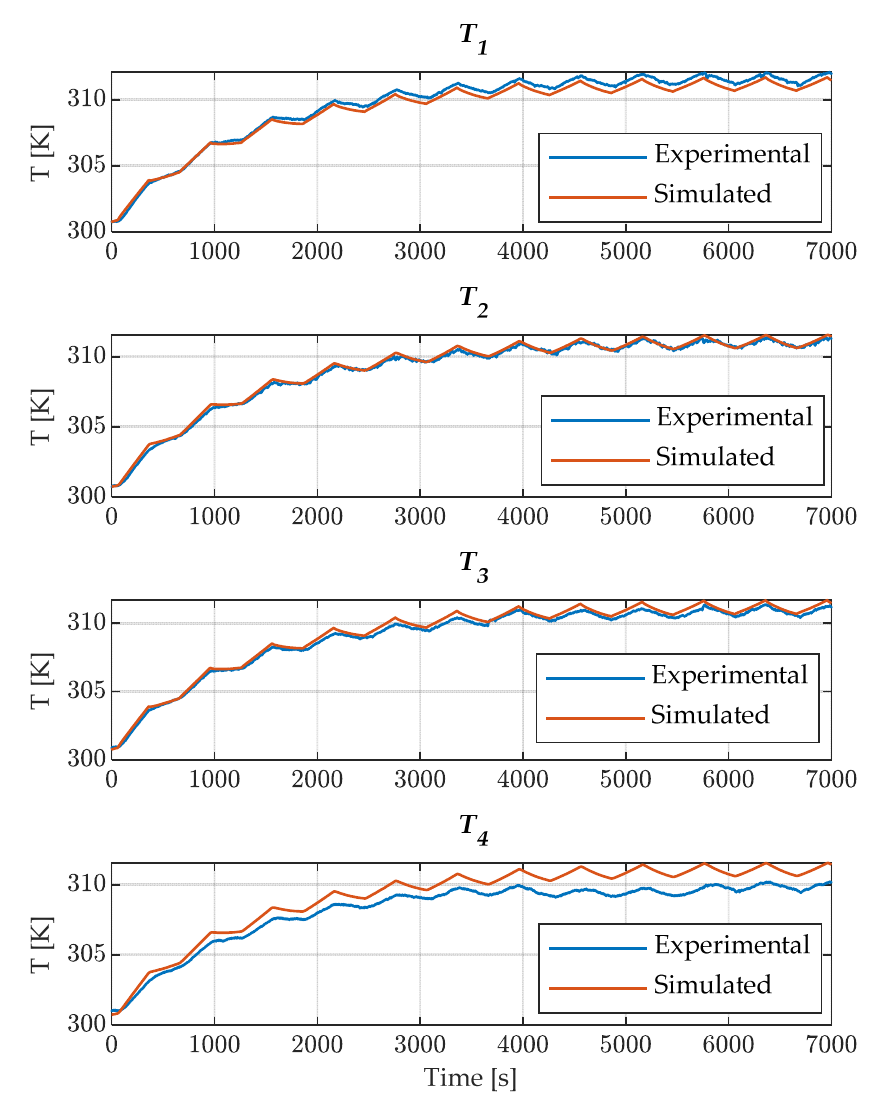
Figure 19. Thermocouples results for the three cells test at 45 A.